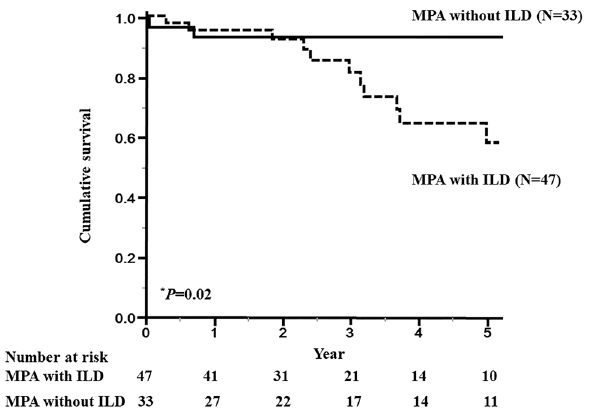
Figure 2. Survival curves of patients with microscopic polyangiitis (MPA) based on the presence of interstitial lung disease (ILD). The 5-year survival rate for MPA patients with ILD (58%) was significantly lower than that for MPA patients without ILD (93%) ( P = 0.02). Solid line: MPA patients without ILD, dashed line: MPA patients with ILD. Survival rates were calculated by the Kaplan–Meier method and compared by log-rank test. * P <